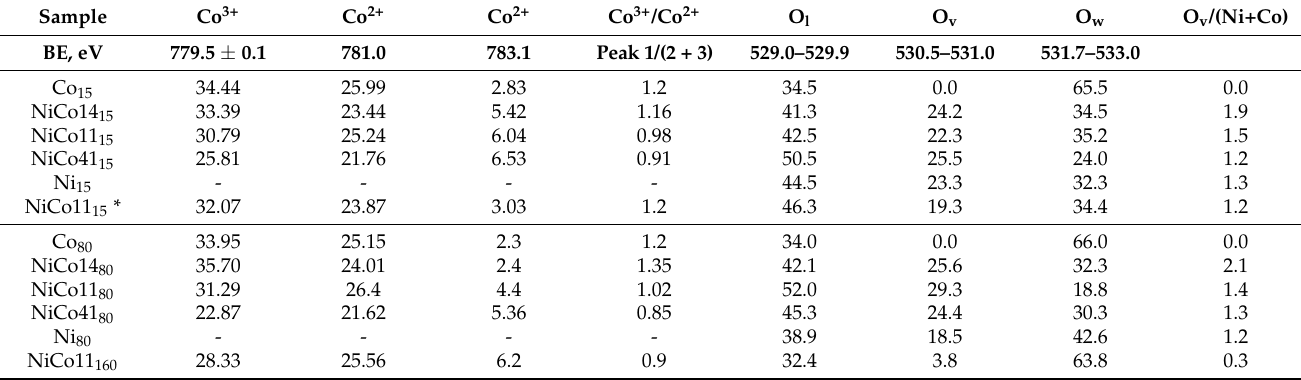
Table 5. Relative atomic concentration of deconvoluted Co 2p and O 1s peaks (at. %), molar ratio of Co 3+ /Co 2+ , and oxygen vacancies O v related to surface concentration of (Ni+Co)